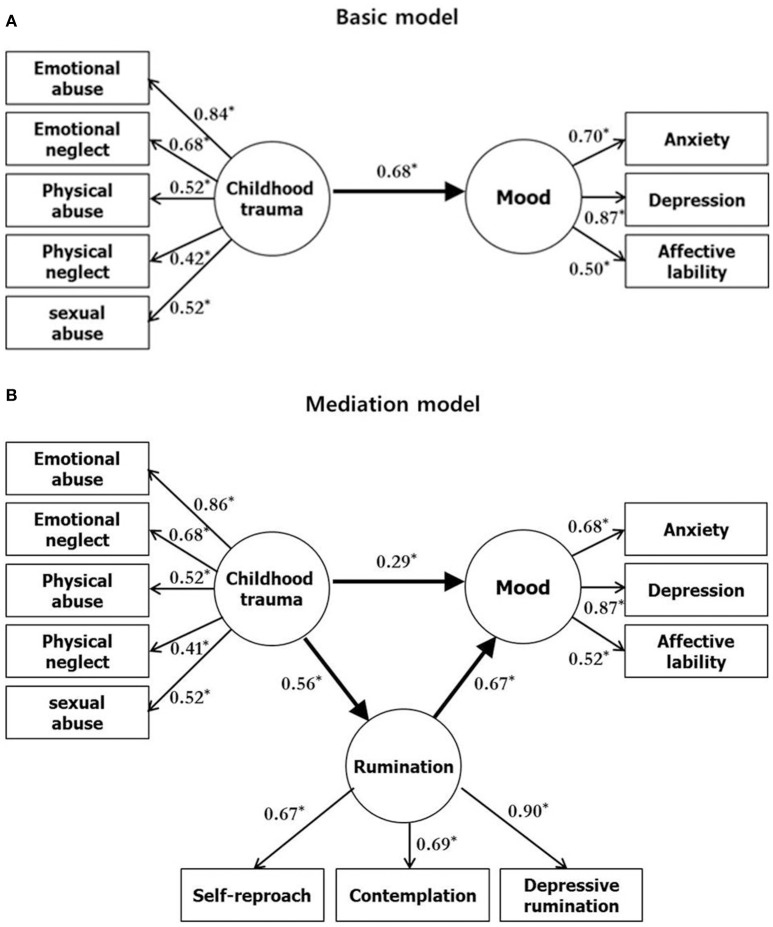
Basic model of the relationship between childhood trauma and mood (A), and mediation model showing rumination as a mediator of the relationship (B). Rectangles represent observed variables. Circles represent latent variables. Numbers on single-headed arrows indicate standardized regression weights. *p < 0.05, multiple regression analysis.